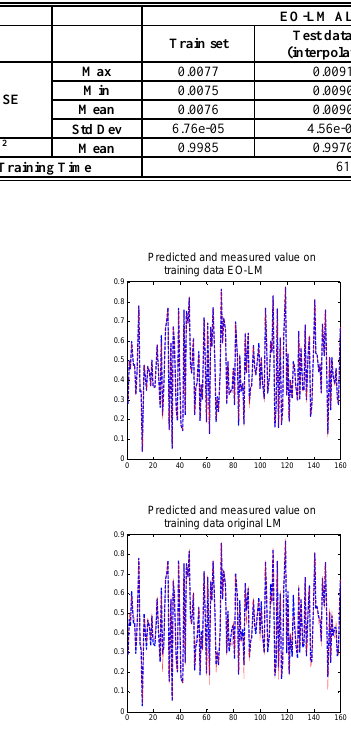
Table 1. Comparison between the EO-LM and LM